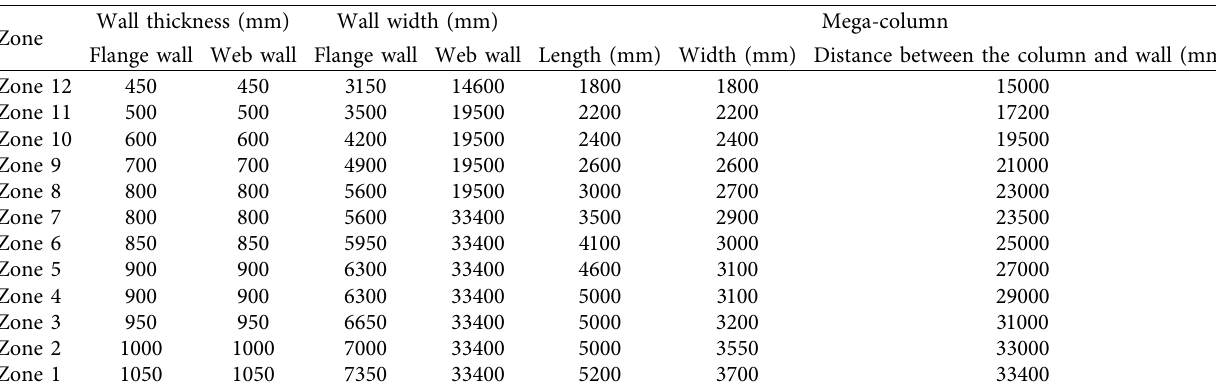
Figure 20: Time history of the top acceleration in the structure without control. Table 9: Column and wall dimensions of the simplified model.